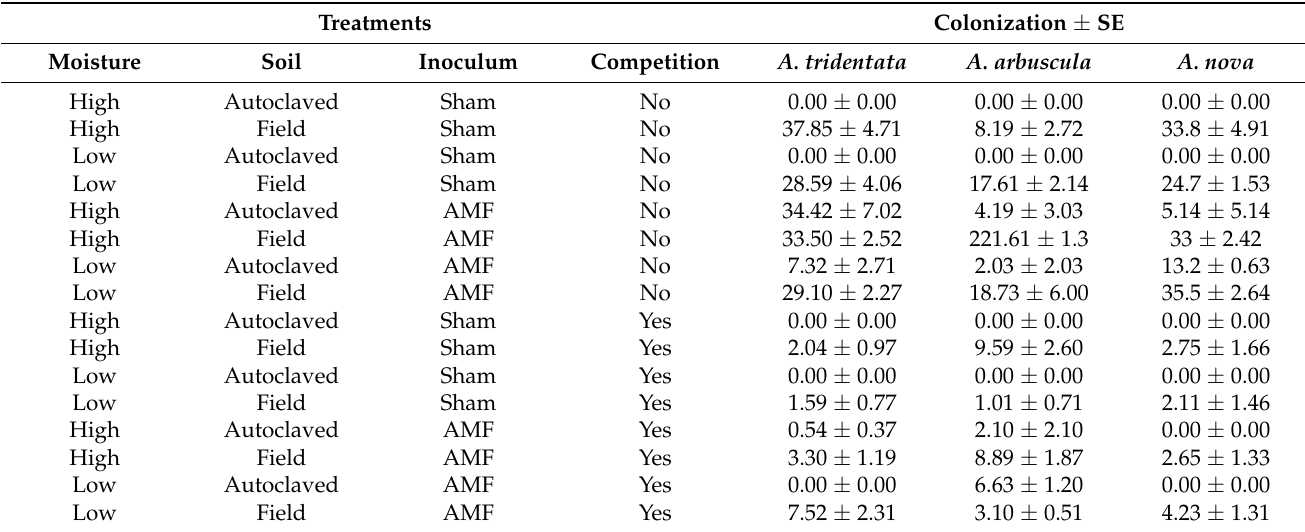
Table 2. Mean percentages and SE of AMF colonization in roots of Artemisia tridentata ssp. wyomin- gensis , A. arbuscula, and A. nova grown for 6 months in different soil, moisture, inoculum, and competition treatments.